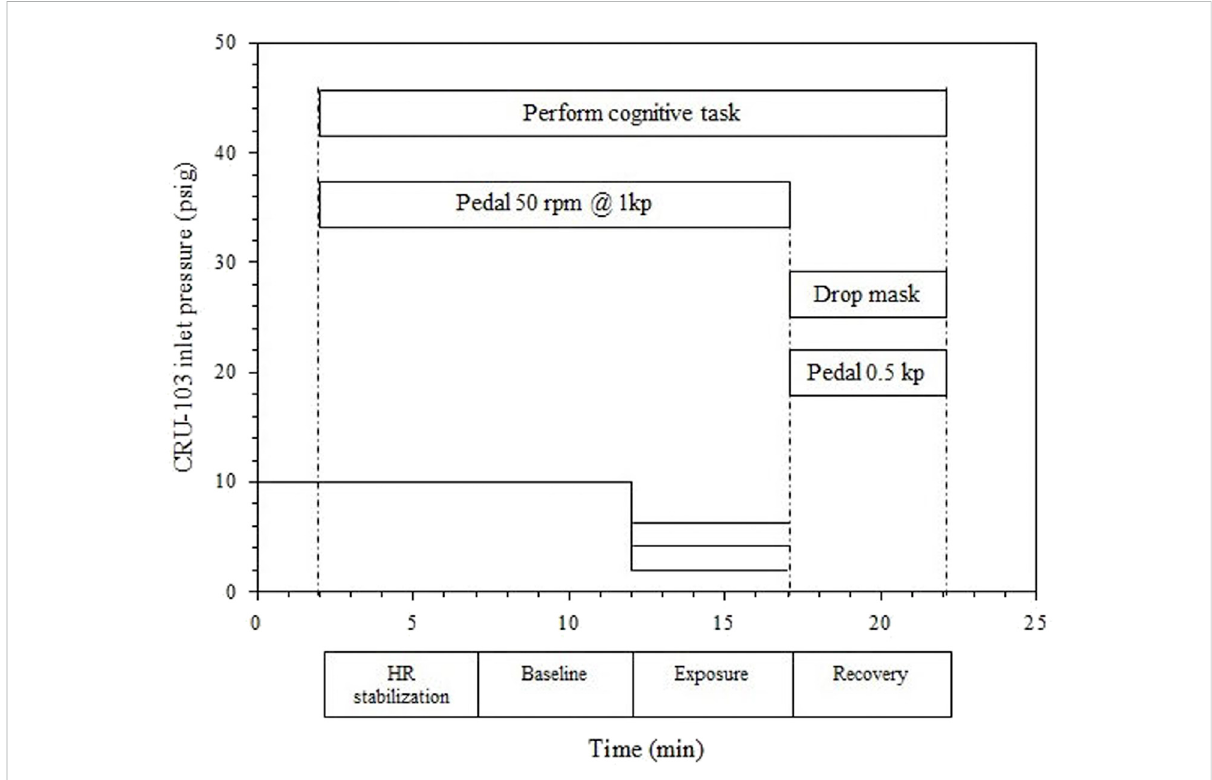
FIGURE 2 Exposure pro fi les for Phase 2 testing in the 6, 4, and 2 psig conditions. Each horizontal line between minutes 12 and 17 represents a separate exposure level, with a single level delivered per study